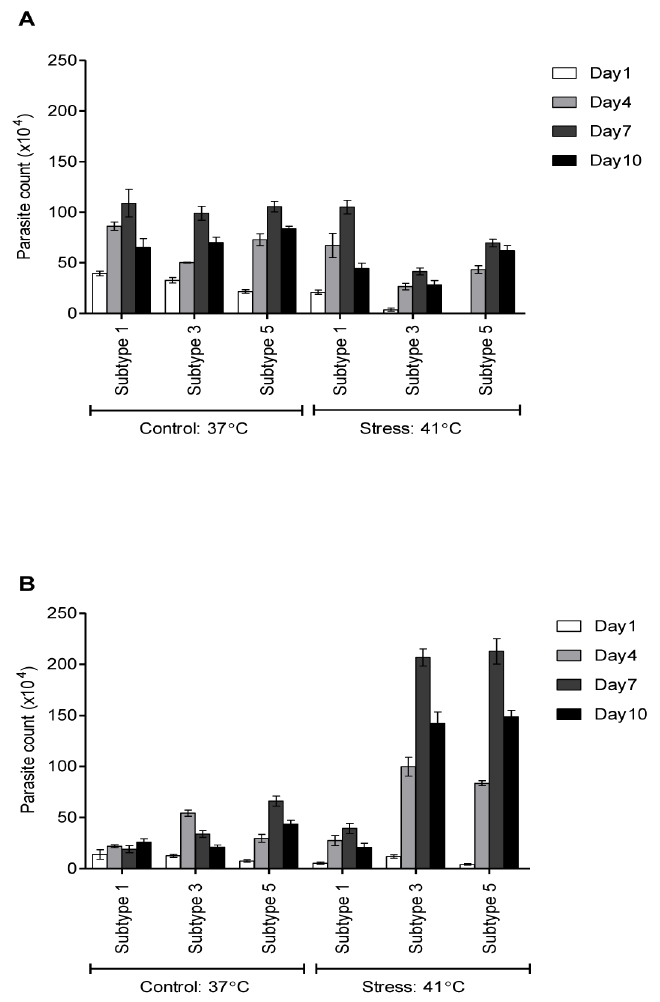
Figure 2. Blastocystis sp. forms in control and thermal stressed isolates. Isolates of subtype 1, 3, and 5 were grown at controlled temperature (37 u C) and thermal stressed temperature (41 u C). (A) Vacuolar form was highly significant in controlled isolates compared to their respective stressed isolates of all the three subtypes. (B) Granular form was highly significant in the thermal stressed isolates of subtype 3 and 5.